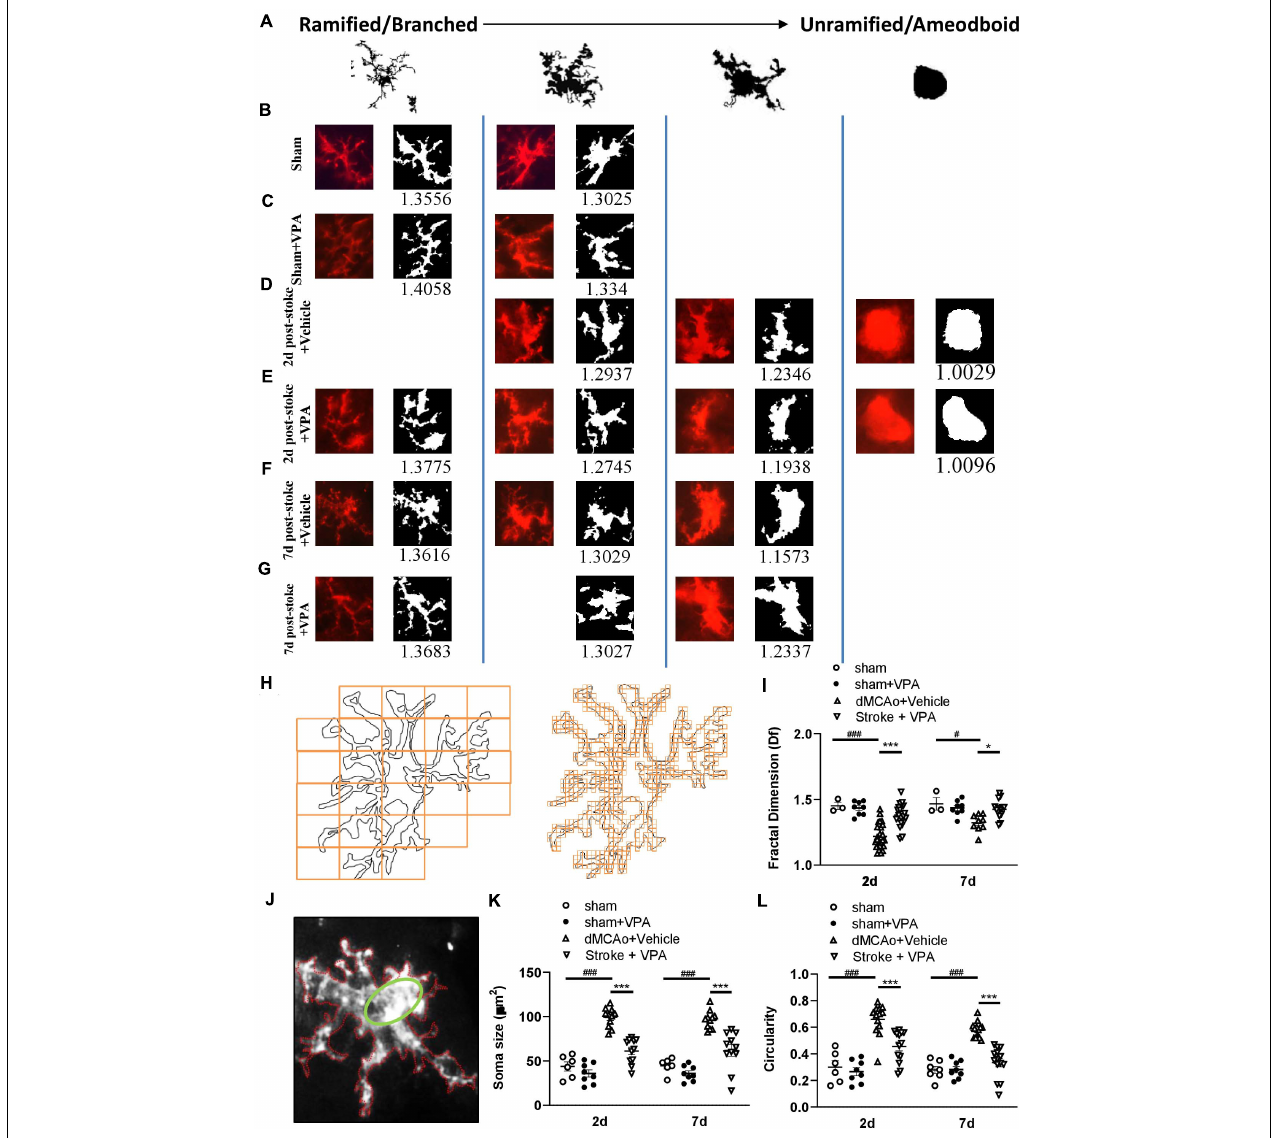
FIGURE 5 | Complexity analysis of CD11b-positive cell morphologies in the peri-infarct cortex with/without VPA administration. (A) Microglia/macrophages are morphologically dynamic cells able to change form from highly ramified to a completely amoeboid-like shape lacking processes. This transition can be very rapid under pathological conditions. The forms illustrated here represent snapshots of a transformation that is reversible at every time point, with variation with each form shown. (B–G) Complexity analysis of microglia/macrophages in CD11b-stained tissue. The process to prepare photomicrographs for complexity analysis: Original photomicrographs were subjected to a series of uniform ImageJ plugin protocols prior to conversion to binary images. Binary images were then analyzed by using FracLac for ImageJ, which quantifies single cell complexity (fractal dimension, fD). The calculated Df of the cell is shown below its binary image. Representative images of morphological changes in CD11b-staining cells within the sham-operated cortex in vehicle-treated rats (B) , sham-operated cortex in VPA-treated rats (C) , peri-infarct cortex at 2 days after 90-min dMCAo in vehicle-treated rats (D) , peri-infarct cortex at 2 days after 90-min dMCAo in VPA-treated rats (E) , peri-infarct cortex at 7 days after 90-min dMCAo in vehicle-treated rats (F) , and peri-infarct at 7 days after 90-min dMCAo in VPA-treated rats (G) . (H) Illustration of FracLac box counting method to derive fractal dimension calculations of a CD11b-positive cell outline. Shape detail is quantified as scale increase, represented by orange boxes. Box counting equation is summarized in Table 1 . (I) Summary data and statistical analysis of fractal dimension at 2 and 7 days after ischemia. Fractal dimension was decreased in the peri-infarct cortex compared with the sham-operated cortex at 2 and 7 days post-stroke. However, VPA treatment restored the fractal dimension of CD11b-positive cells in the peri-infarct cortex at 2 days and 7 days post-stroke. All post hoc analyses are reported in the figure (2 days: ### p < 0.001 vs. sham and dMCAo + vehicle; *** p < 0.001 vs. dMCAo + vehicle and dMCAo + VPA; 7 days: # p < 0.05 vs. sham and dMCAo + vehicle; * p < 0.05 vs. dMCAo + vehicle and dMCAo + VPA). (J) The schemes illustrate graphically the calculation base for the circularity index for the manual analysis. Q22. (K,L) Soma size and circularity index were increased in the peri-infarct cortex compared with the sham-operated cortex at 2 and 7 days post-stroke. However, VPA treatment decreased the soma size and circularity index of CD11b-positive cells in the peri-infarct cortex at 2 and 7 days post-stroke. All post hoc analyses are reported in the figure (2 days: ### p < 0.001 vs. sham and dMCAo + vehicle; *** p < 0.001 vs. dMCAo + vehicle and dMCAo + VPA; 7 days: ### p < 0.001 vs. sham and dMCAo + vehicle; *** p < 0.001 vs. dMCAo + vehicle and dMCAo + VPA). Twenty-five to thirty cells per region of n = 4 rats in each